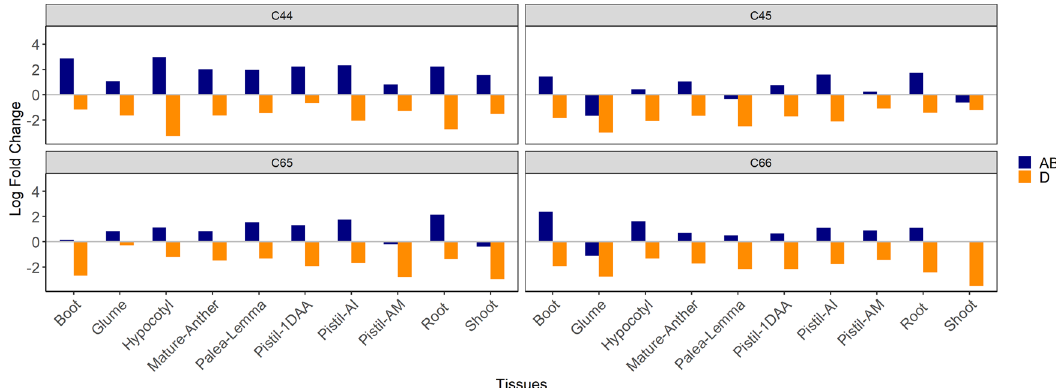
Fig. 4 Comparison of ratios of triads signi fi cantly biased towards AB and D subgenomes between genomic backgrounds (parents vs SHWs). The ratios are presented as log fold change (LogFC) values. A LogFC > 0 indicates more triads are biased towards the AB subgenome in the SHW background than the parental background and a LogFC < 0 indicates more triads are biased towards the AB subgenome in the parental background than the SHW, similarly for D subgenome. C44, C45, C65 and C66 are the four SHWs used for the study. The navy blue and dark orange bars represent the triads showing signi fi cant expression bias towards AB and D subgenomes, respectively. Pistil-1DAA pistil-one day after anthesis, Pistil-AM pistil-when anthers are at mature stage, Pistil-AI pistil-when anthers are at immature stage, Boot head at boot